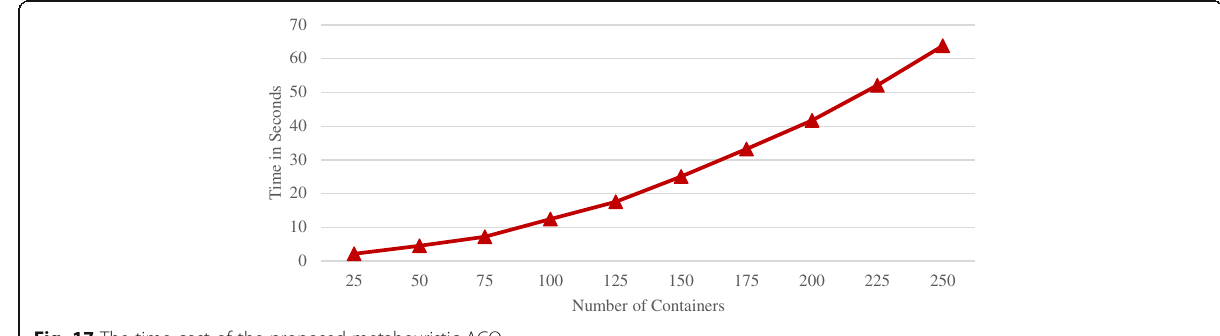
Fig. 17 The time cost of the proposed metaheuristic